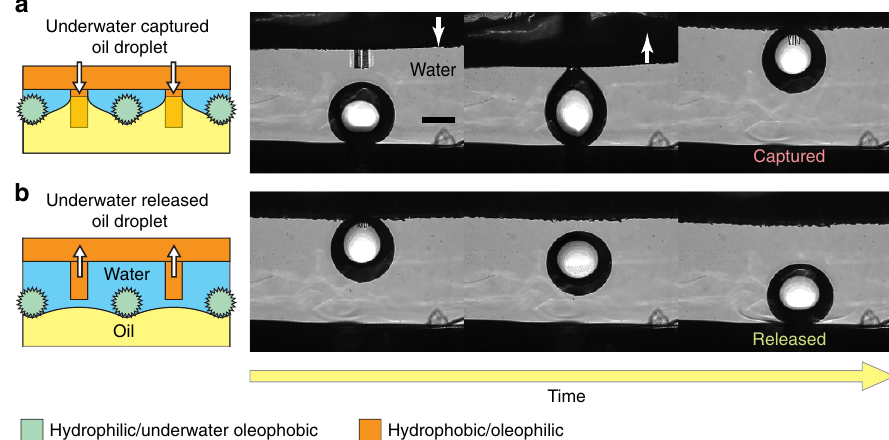
Figure 4 | The manipulation of oil droplets underwater using an MRS. Schematic illustrations and time-sequence images showing ( a ) the underwater capture of a 5- m l droplet of DCE using an MRS with hydrophobic fibres and ( b ) the subsequent release of the DCE droplet underwater. Scale bar,